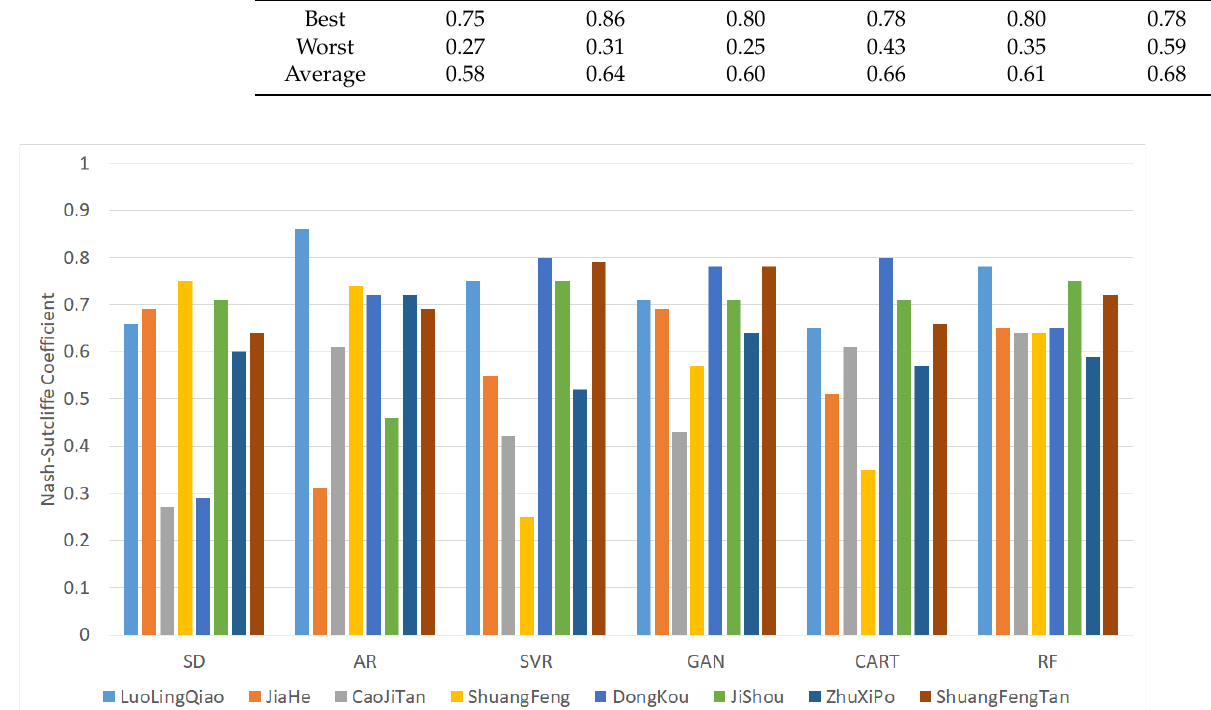
Figure 8. Validation results of regionalization schemes.